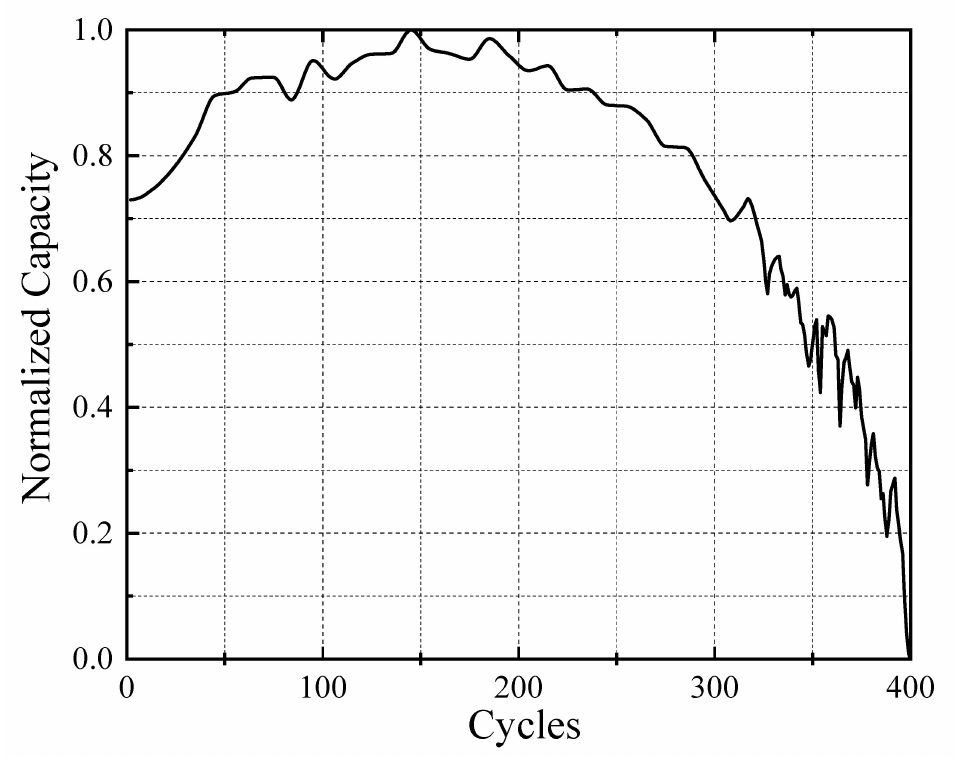
Figure 6. Change trend of battery